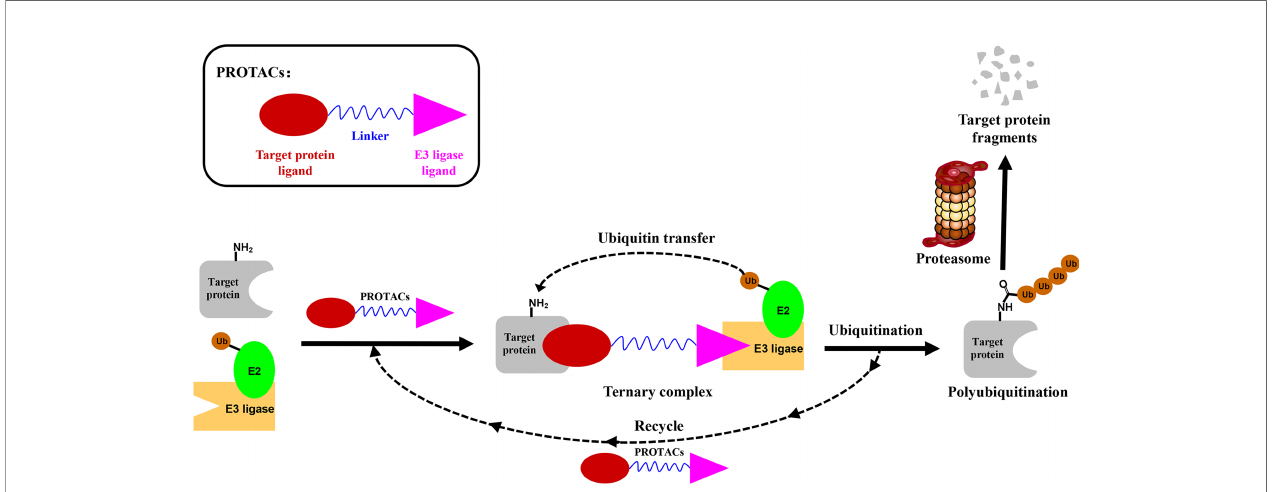
FIGURE 1 | Schematic diagram of Proteolysis Targeting Chimeras (PROTACs) strategy. PROTACs comprise two ligands joined via a fl exible chemical linker (blue font part), with one ligand (red font part) binding to the target protein and the other (violet font part) binding to the E3 ubiquitin ligase, followed by poly-ubiquitination and proteasome degradation of target protein.